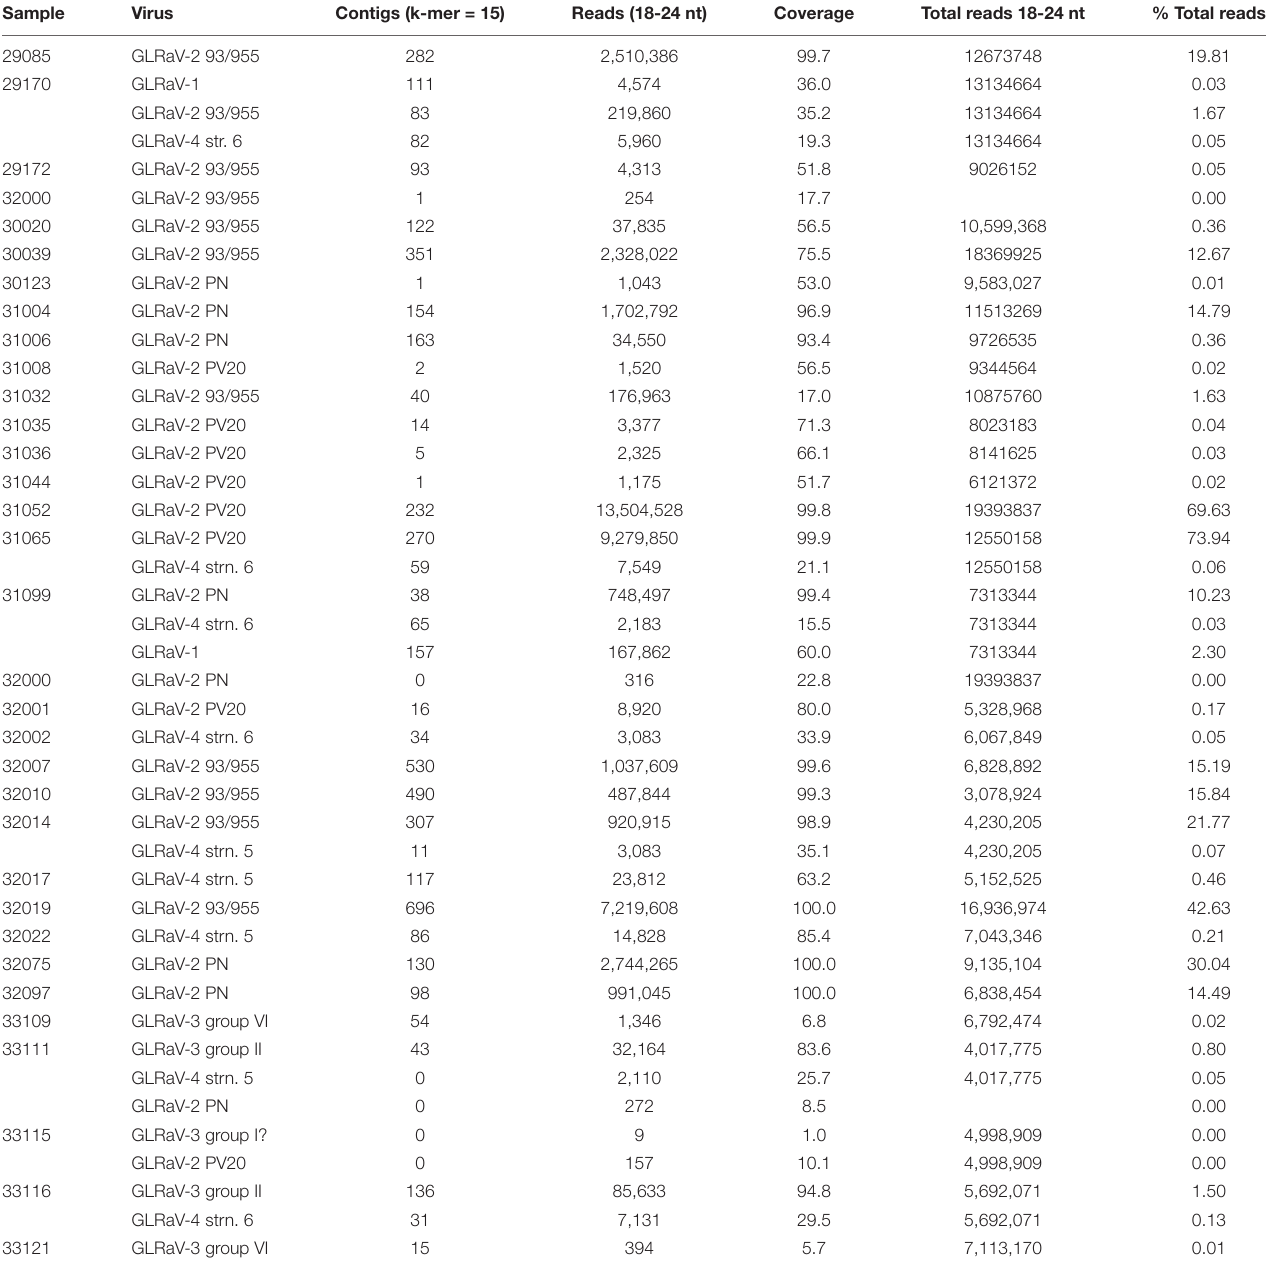
TABLE 1 | Quantitation of contigs, and reads and percentage of genome coverage aligning to GLRD viruses.